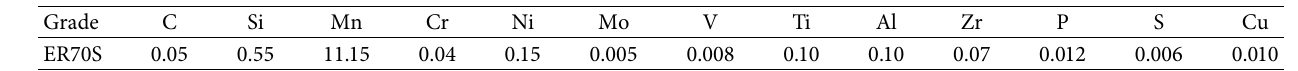
Table 2: Chemical composition of filler electrode ER70S.